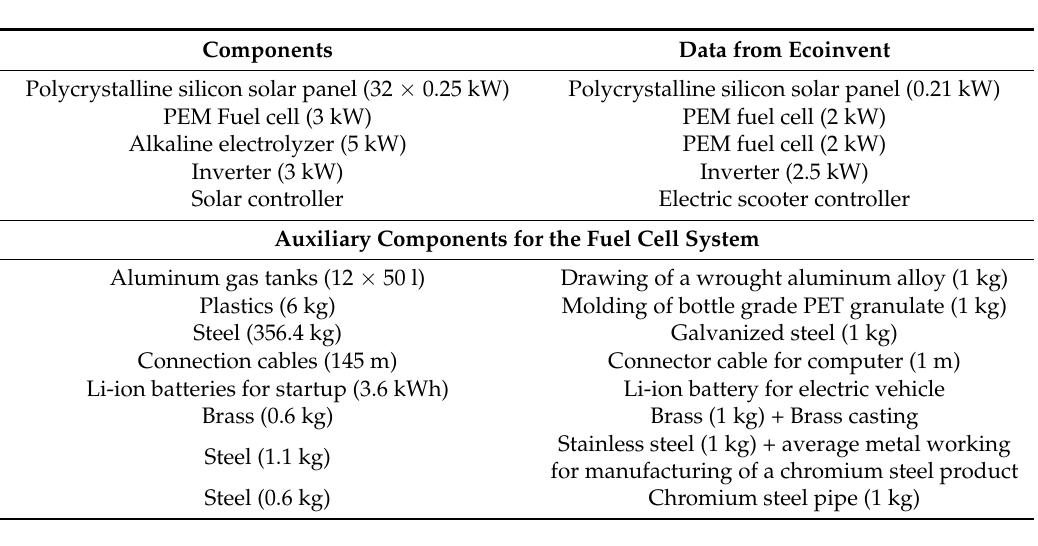
Table 3. Inventory for the fuel cell- based stationary system.